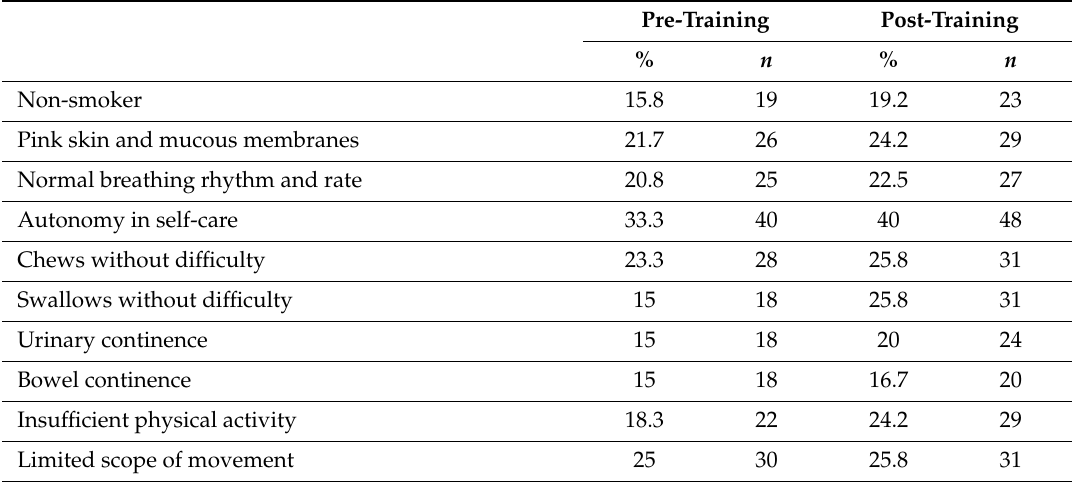
Table 3. Most frequently selected normal characteristics in the initial patient